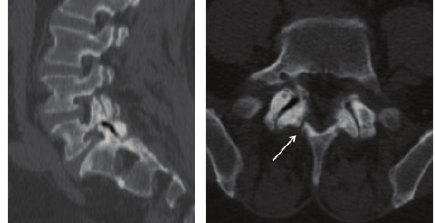
Figure 3: Preoperative CT. L5 interarticularis right pars spondylol- ysis (white arrow) and severe facet joint osteoarthritis with vacuum sign.